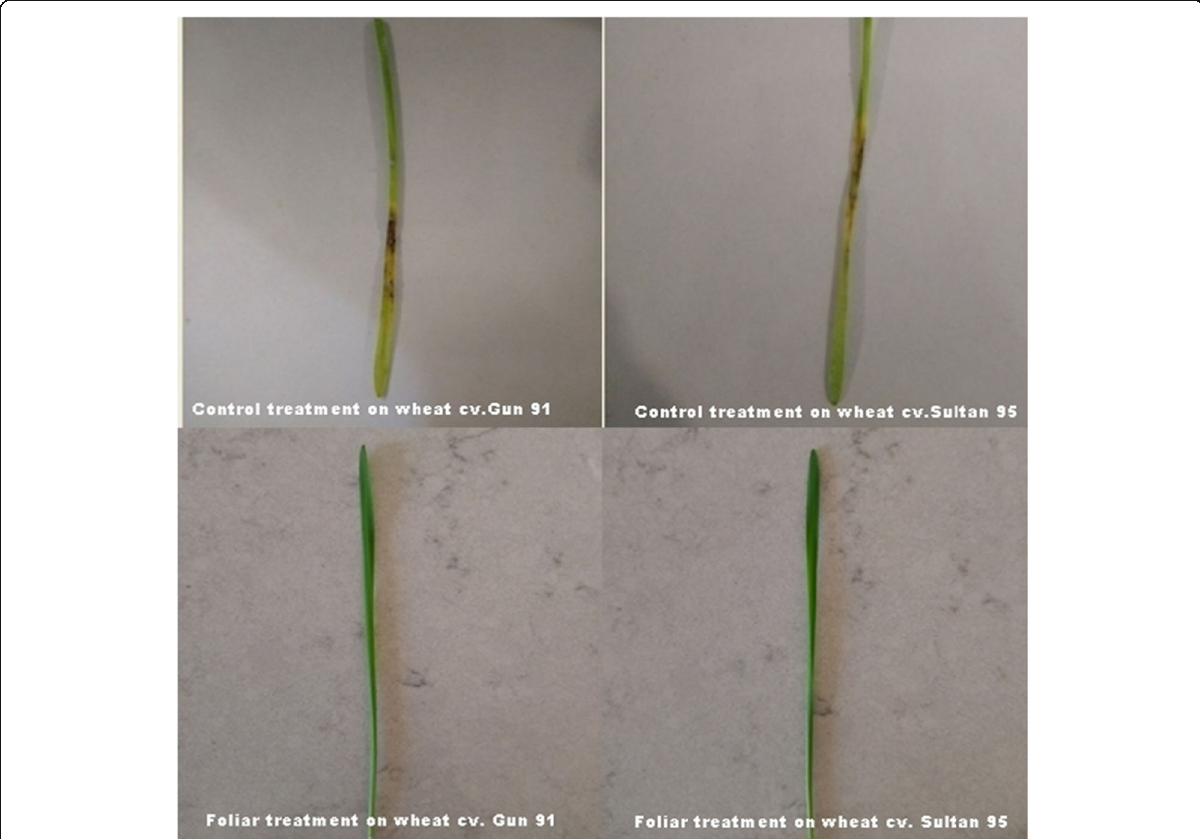
Fig. 2 The leaf infection caused by F . graminearum in wheat cultivars after the foliar treatments with S . cerevisiae + S . fimicola at 1 × 10 9 spores/ ml and the control